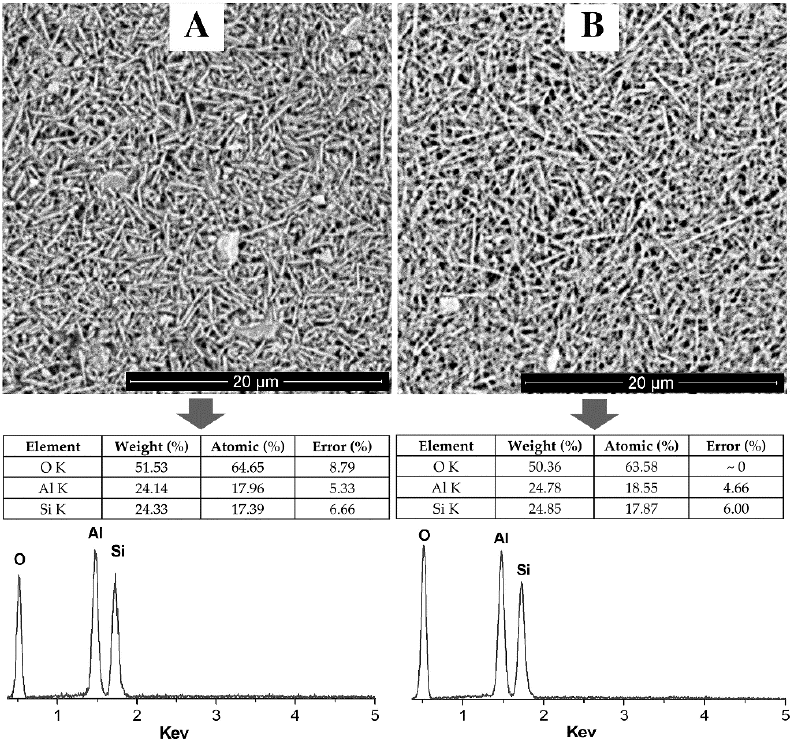
Figure 5. SEM-EDS images of the UPS and LOS samples with the size fraction <2 µm. LOS sample ( A ) and UPS sample ( B ). O—oxygen; Al—aluminum; Si—silicon.